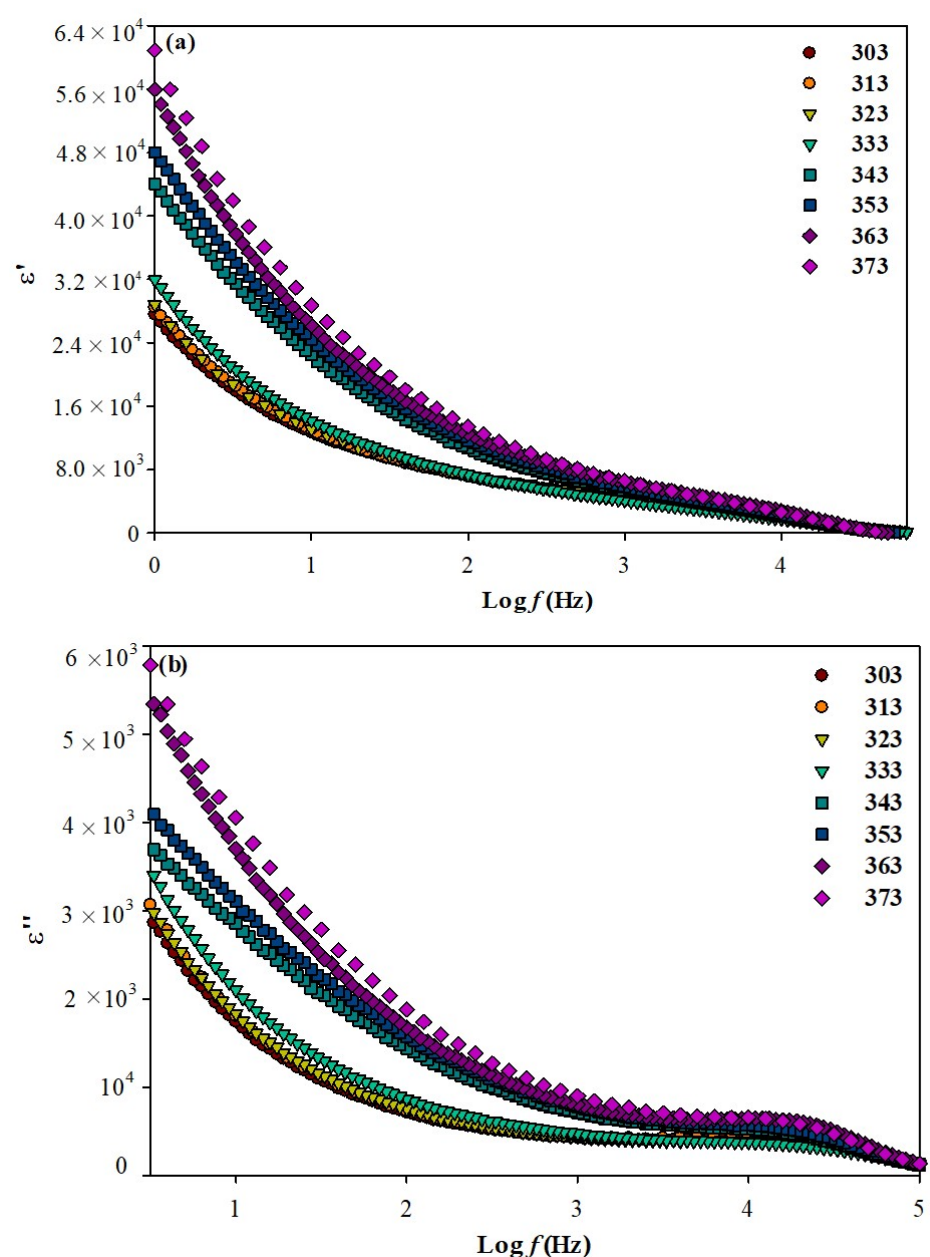
Figure 3. Frequency dependence of ( a ) dielectric constant and ( b ) dielectric loss at various temper- atures for the highest conducting ILGPE film with 60% percentage ratio of [BMIM][BF 4 ] to PVDF-